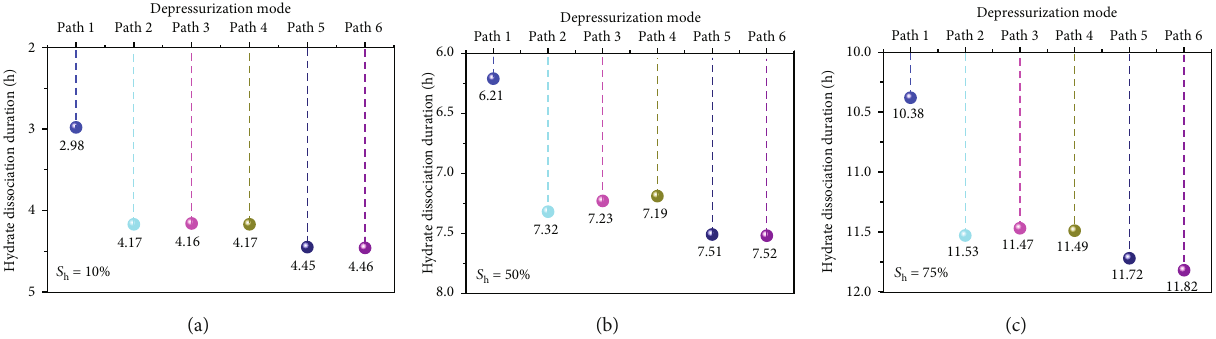
Figure 11: The hydrate evolutionary behaviors during the 3rd depressurization path when initial hydrate saturation is 75%. Point B represents the center of the far side of mode on the section a ‐ a .